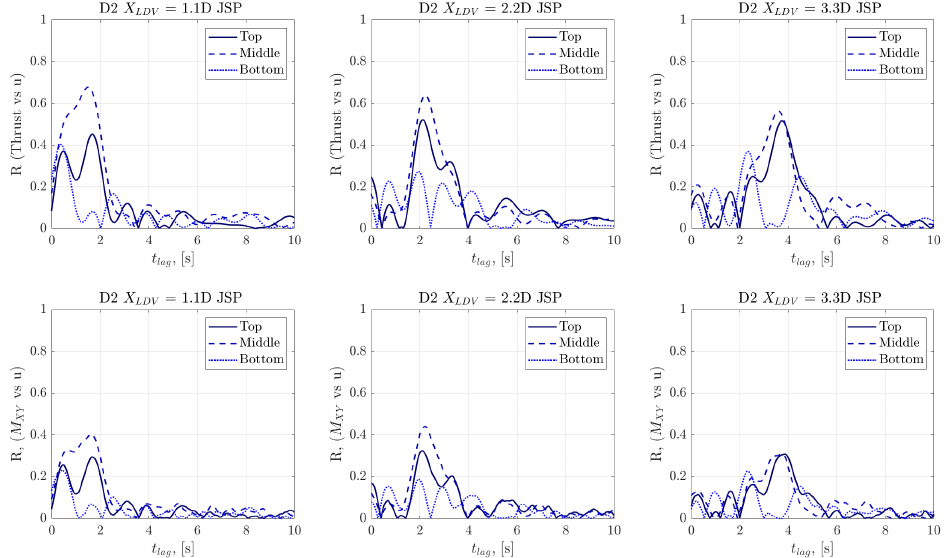
Figure 12. Development of the cross-covariance coefficient at lag values differing between LDV measurements and rotor torque measurements. Upper charts show the thrust, whereas the lower charts show out-of-plane ( M XY ) BRBM correlations with the fluid velocity